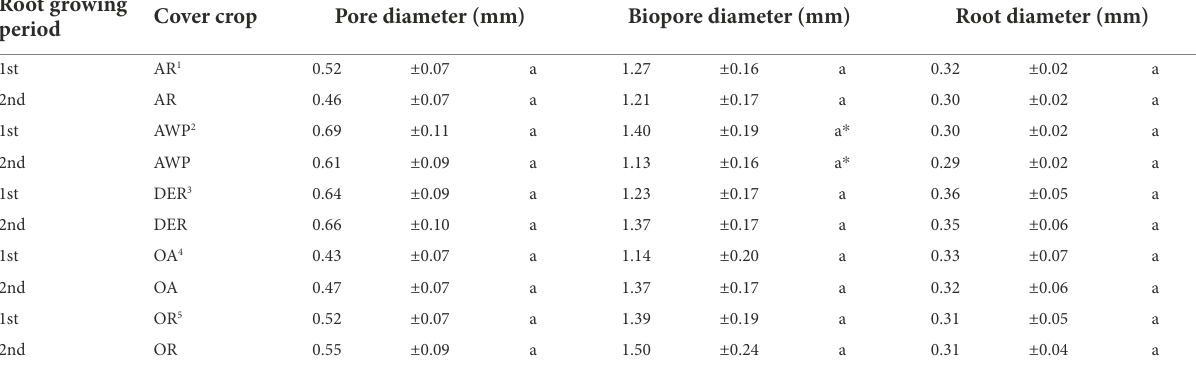
TABLE 2 Mean diameter of pores, biopores and roots (based on volumes) in cores of the five different plants. Root growing